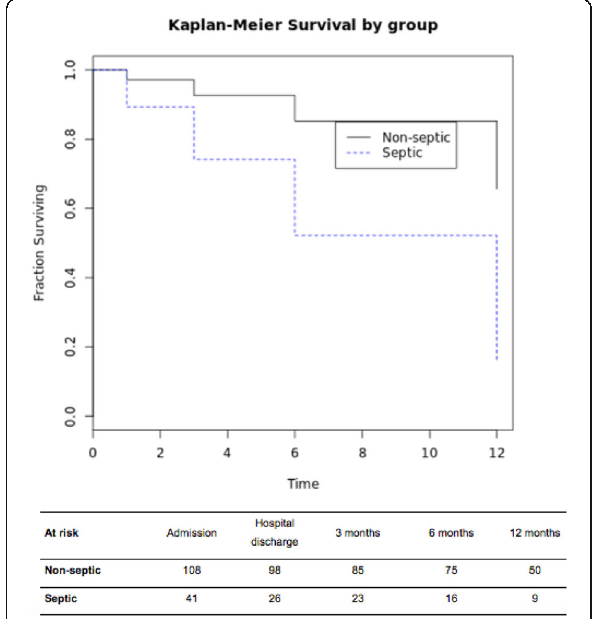
Fig. 1 (abstract P22). Kaplan-Meier survival curves of septic × non- septic patients with SAH. Log Rank test p<0.0001. Time to death or last follow-up in months